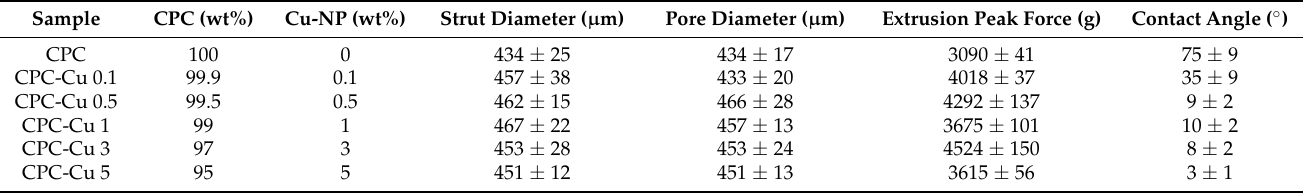
Table 1. Formulation and preliminary characterization of CPC and copper loaded CPC at different